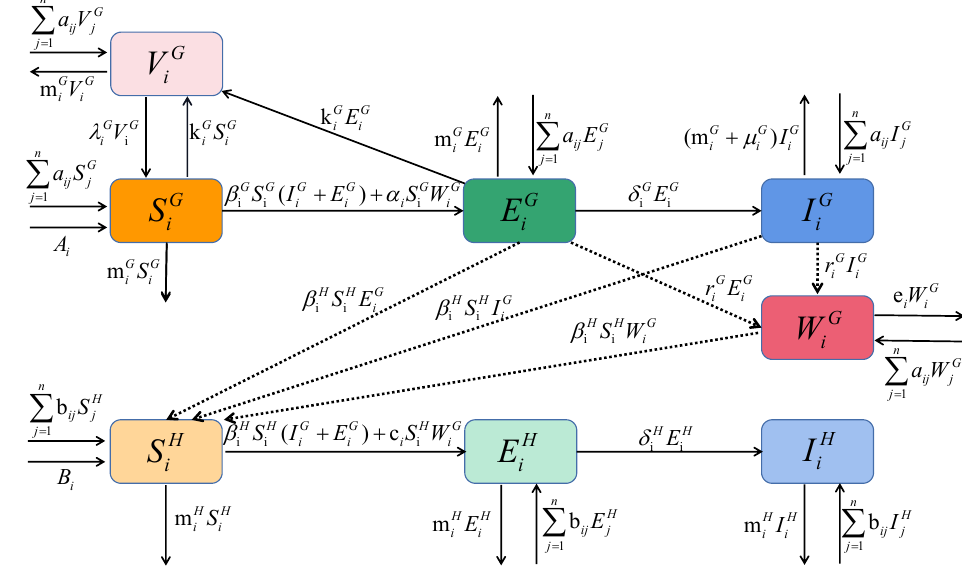
Figure 2. The transportation of brucella between sheep and from sheep with brucellosis to humans and from patch to patch due to the transportation of sheep in patch i